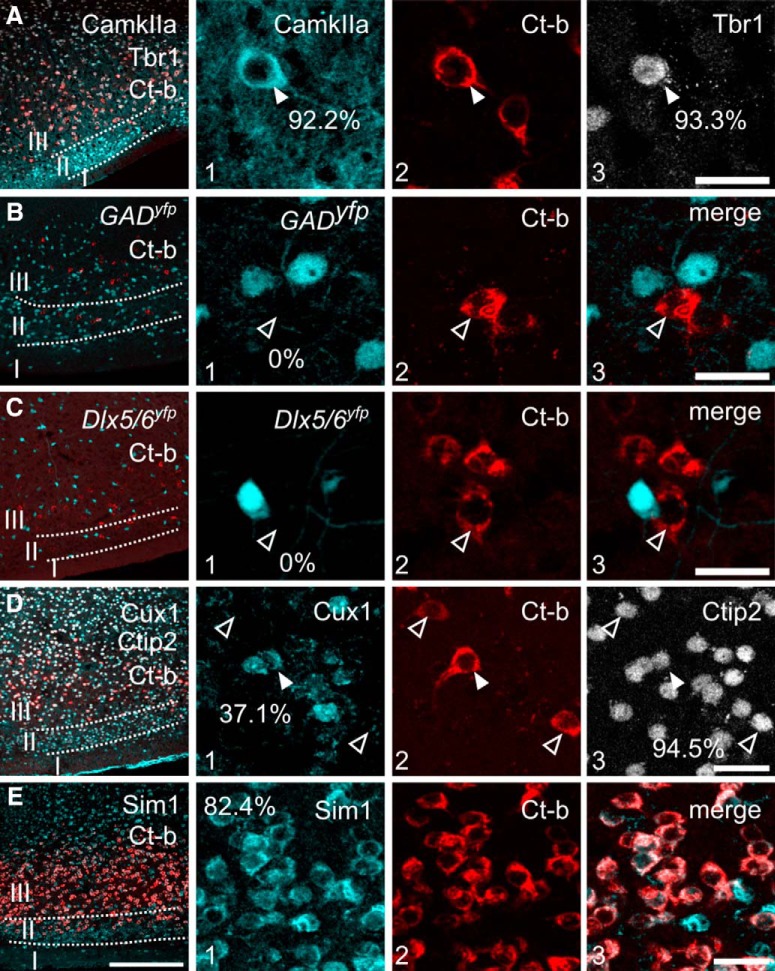
Molecular phenotypes of PmCo–AOB projection neurons. A, PmCo corticobulbar projection neurons (ACPs) labeled with Ct-b after AOB retrograde tracing. Ct-b-labeled PmCo neurons (red) express the excitatory markers CaMKIIa (cyan, 92.2%) and Tbr1 (gray, 93.3%). B, C, Ct-b-labeled neurons in the PmCo do not express YFP in GADcre;Ryfp or Dlx5/6cre;Ryfp mouse lines (cyan), confirming their excitatory phenotype. D, PmCo-Ct-b-labeled neurons express Cux1 (cyan, 37.1%) and Ctip2 (gray, 94.5%), typical cortical neuron markers in layer II–IV and V and VI, respectively. All Cux1+ PmCo neurons coexpressed Ctip2. E, Expression of the gene Sim1 reaches ca. 82.4% in PmCo Ct-b-positive cells. For each count, tissue collected (three to four sections) from three Ct-b-injected mice was used. Scale bars: left, 20 μm; right, 200 μm.